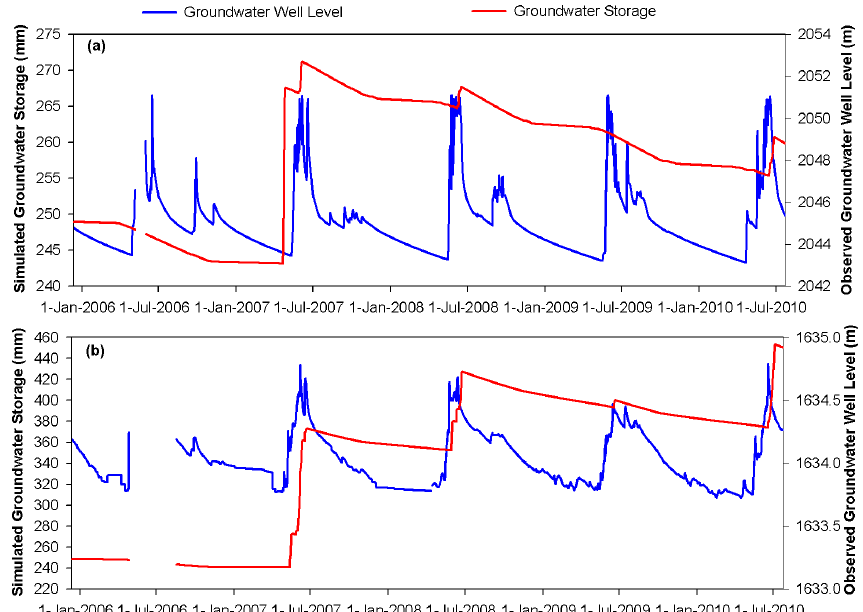
Fig. 9. Comparisons of the observed hourly groundwater level fluctuation and simulated hourly groundwater storage during the period 13 December 2005–21 July 2010. (a) Well GW305 and (b) well GW386.